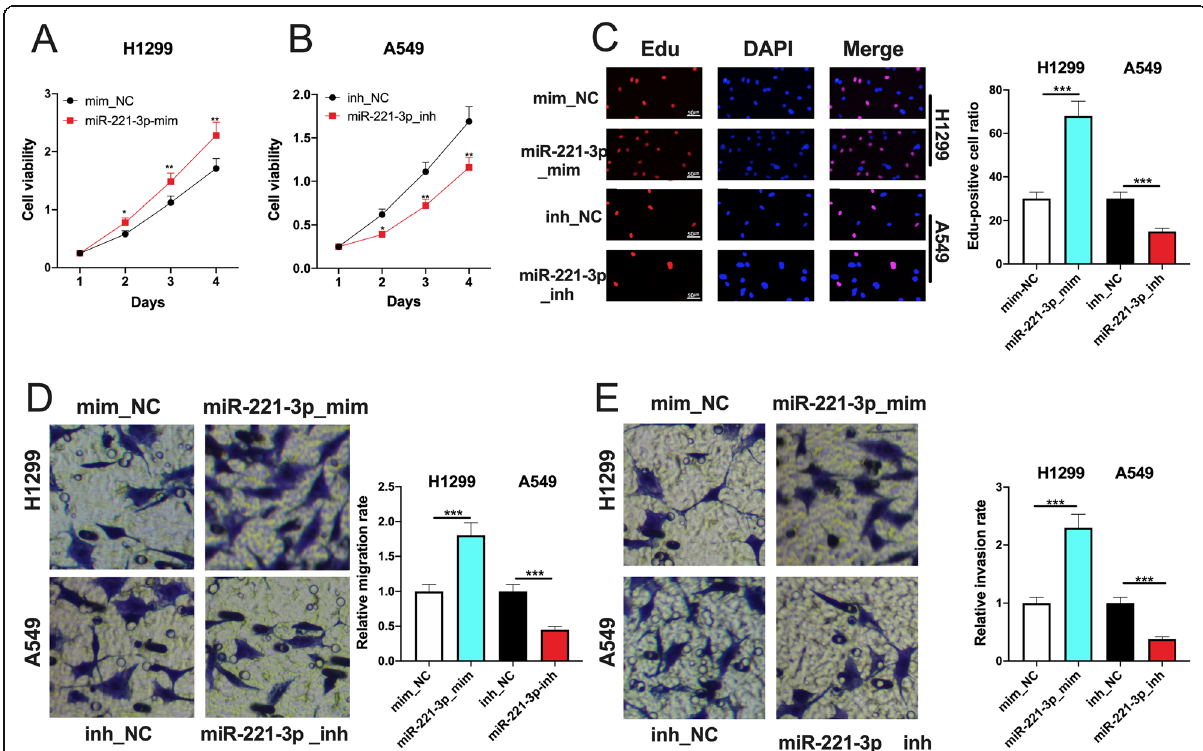
Fig. 4 Effects of miR-221-3p on NSCLC cells. a , b CCK-8 experiment was adopted to detect the effects of overexpression or inhibition of miR-221- 3p on the viability of A549 and H1299 cells, respectively. c EdU experiment was applied to detect the effect of overexpression or inhibition of miR-221-3p on the proliferation of A549 and H1299 cells, respectively. d , e Transwell expeimrnt was employed to detect the effects of overexpression or inhibition of miR-221-3p on the migration and invasion of A549 and H1299 cells, respectively. *, **, *** represent p < 0.05, p < 0.01, and p < 0.001,